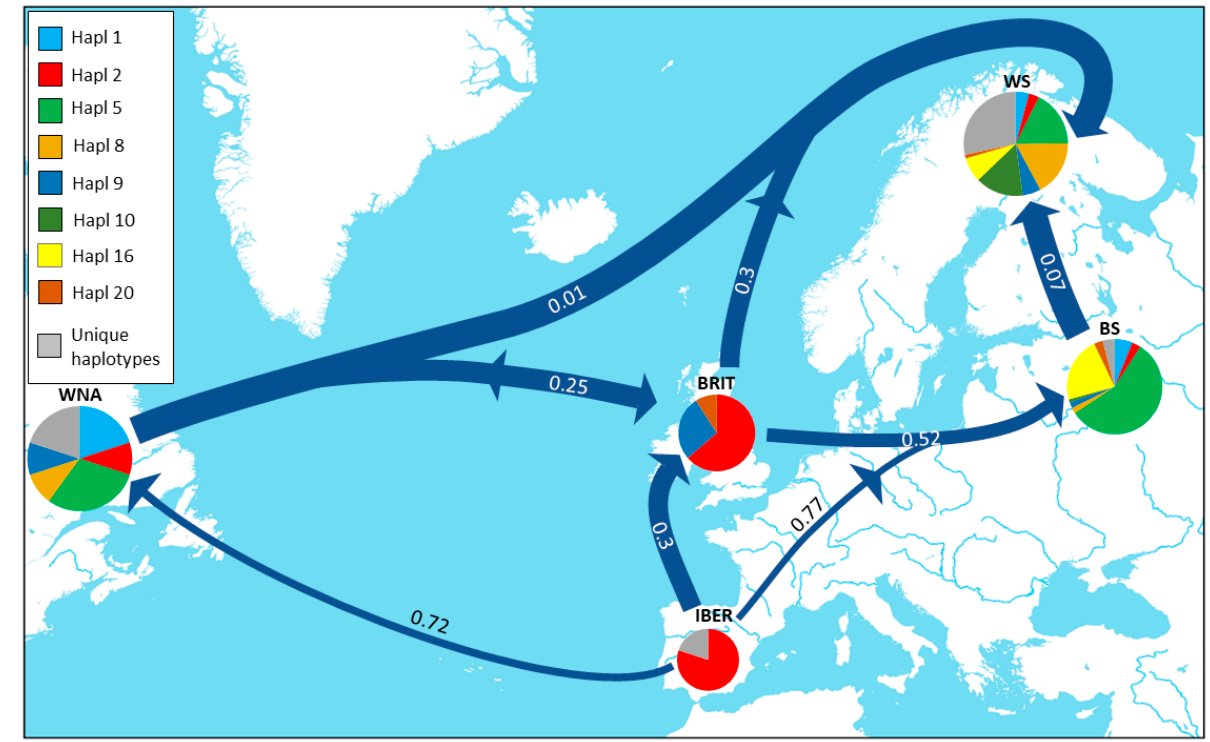
Figure 1. Map showing the distribution of COI haplotypes among Margaritifera margaritifera groups of populations and putative colonization patterns of the species. WNA—West–North Atlantic ( n = 10), IBER—Iberia ( n = 20), BRIT—Britain ( n = 20), BS—Baltic Sea ( n = 99), WS—White Sea ( n = 317). For details, see Table S1. Values within or near arrows indicate FST’s distances. Arrow widths inversely correspond to FST’s values. The map was created using ESRI ArcGIS 10 software (Environmental Systems Research Institute, Redlands, CA, USA); the topographic base of the map was created with Natural Earth Free Vector and Raster Map Data (https://www.naturalearthdata.com, accessed on 15 March 2022).